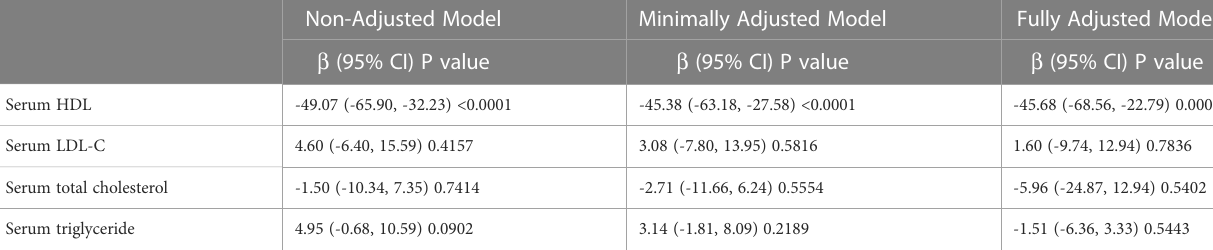
TABLE 2 The correlation between serum lipid and blood eosinophil counts in three weighted regression